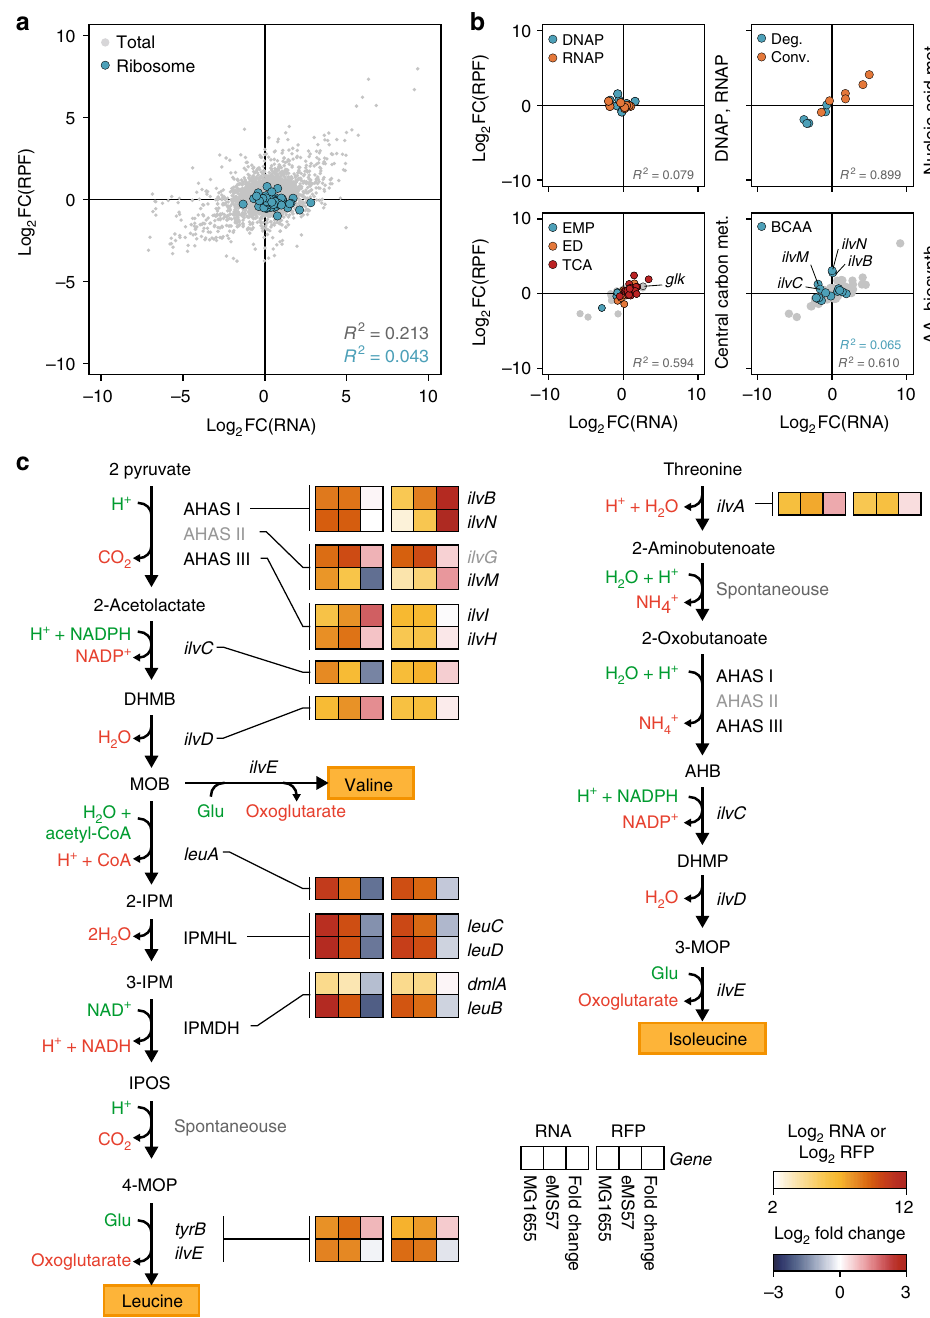
Fig. 4 Post-transcriptional changes in eMS57 analyzed by ribosome pro fi ling. a Correlation between translation and transcription changes in eMS57 compared to that in MG1655. Translational changes in eMS57 generally showed a weak correlation with transcriptional change (Total, Pearson ’ s r 2 of 0.213). Transcription of ribosomal proteins was upregulated, whereas translation remained relatively unchanged. Each dot indicates a gene. Pearson ’ s correlation constants ( r 2 ) between transcription and translational changes in total genes (gray dots) and ribosome (blue dots) are presented. FC: fold change (eMS57/MG1655). b Correlation between transcription and translation changes in DNA synthesis machinery (DNAP), transcription machinery (RNA polymerase), nucleic acid metabolism, central carbon metabolism, and amino acid biosynthetic pathway. No changes were observed in the transcriptional and translational levels of DNA synthesis and transcription machinery. Translation of genes responsible for nucleic acid and central carbon metabolism correlated linearly to transcriptional change. BCAA biosynthetic genes were translated differently than transcription in eMS57. Each dot indicates a gene and dots are colored by their function or pathway. Correlation between transcription and translational changes were examined by Pearson ’ s correlation ( r 2 ). FC: fold change (eMS57/MG1655). c Transcription and translation level of BCAA biosynthesis pathway. Translation of valine- resistant acetohydroxy acid synthase I (AHAS I) were markedly upregulated in eMS57. DHMB: 2,3-dihydroxy-3-methylbutanoate, MOB: 3-methyl-2-